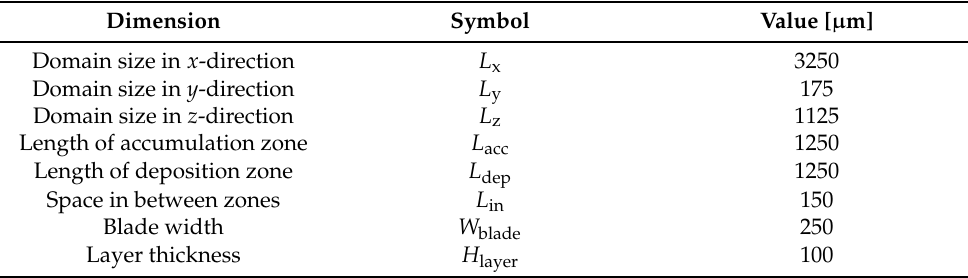
Table 1. Characteristic dimensions of the computational